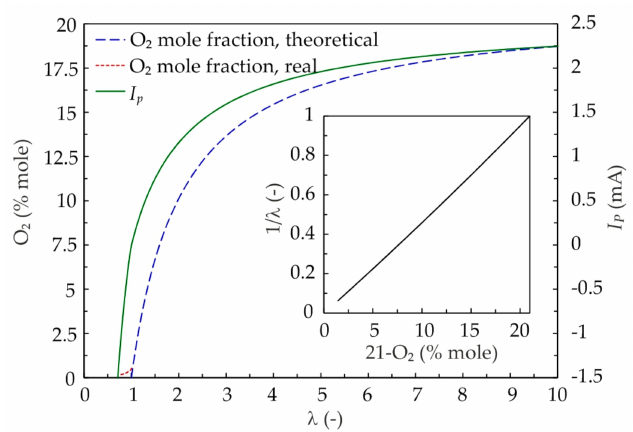
Figure 2. Characteristics of a wide-band UEGO sensor. Theoretical O 2 mole fraction calculated using Equation (1). Real O 2 mole fraction from technical report [23]. Pump current from ETAS (ETAS GmbH, Stuttgart, Germany) LA4 lambda meter manual